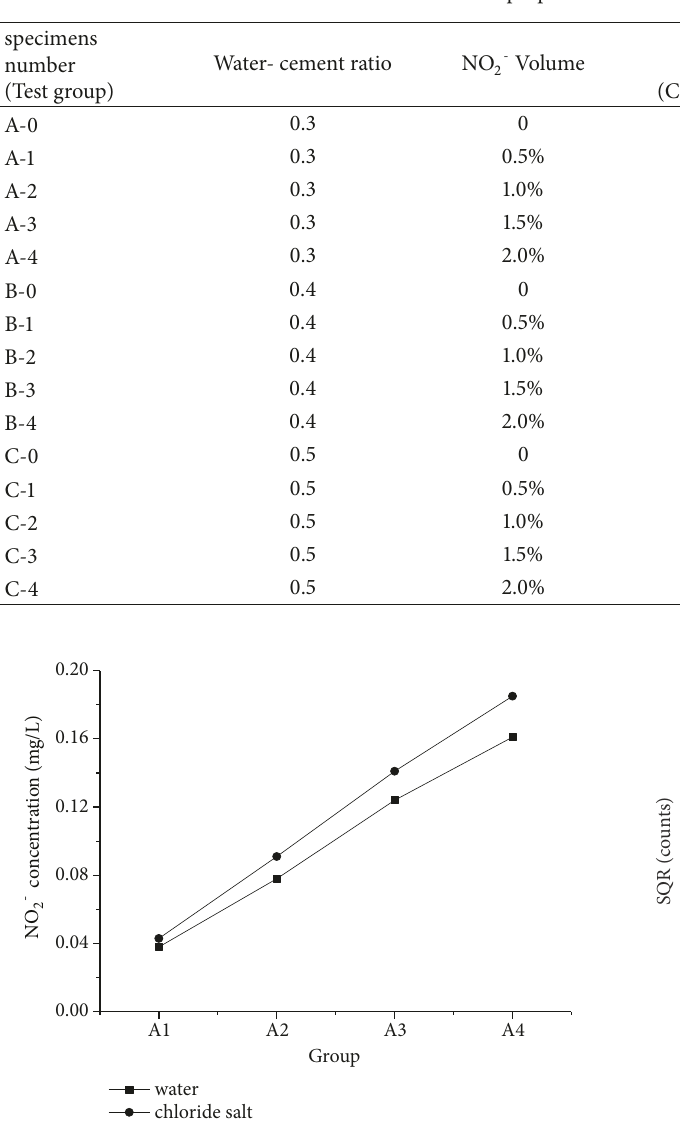
Table 2: Mix proportions of cement paste specimens.